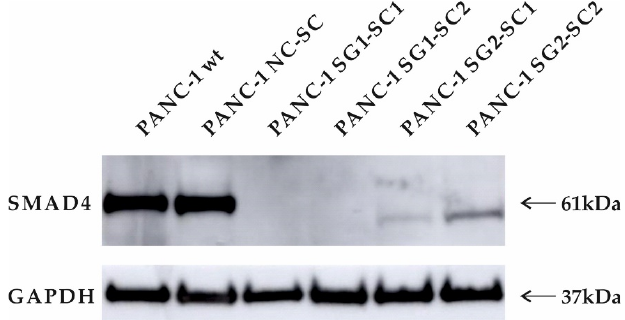
Figure A1. Confirmation of PDAC SMAD4 ( − / − ) knock-out mutants by Western blot. Lower panel: GAPDH control shows homogeneous loading of the protein in each line. Upper panel: wt control and non-matching control (lines 1 and 2) show a distinct 61 kDa band of SMAD4. The selected clones (SC) of construct SG1 (lines 3 and 4) do not show any signal, indicating a homogeneous knock-out of the SMAD4 gene in these two clones, while lines 5 and 6 showed much weaker bands slightly lower than the expected size, indicating a truncated variant of the SMAD4 gene and